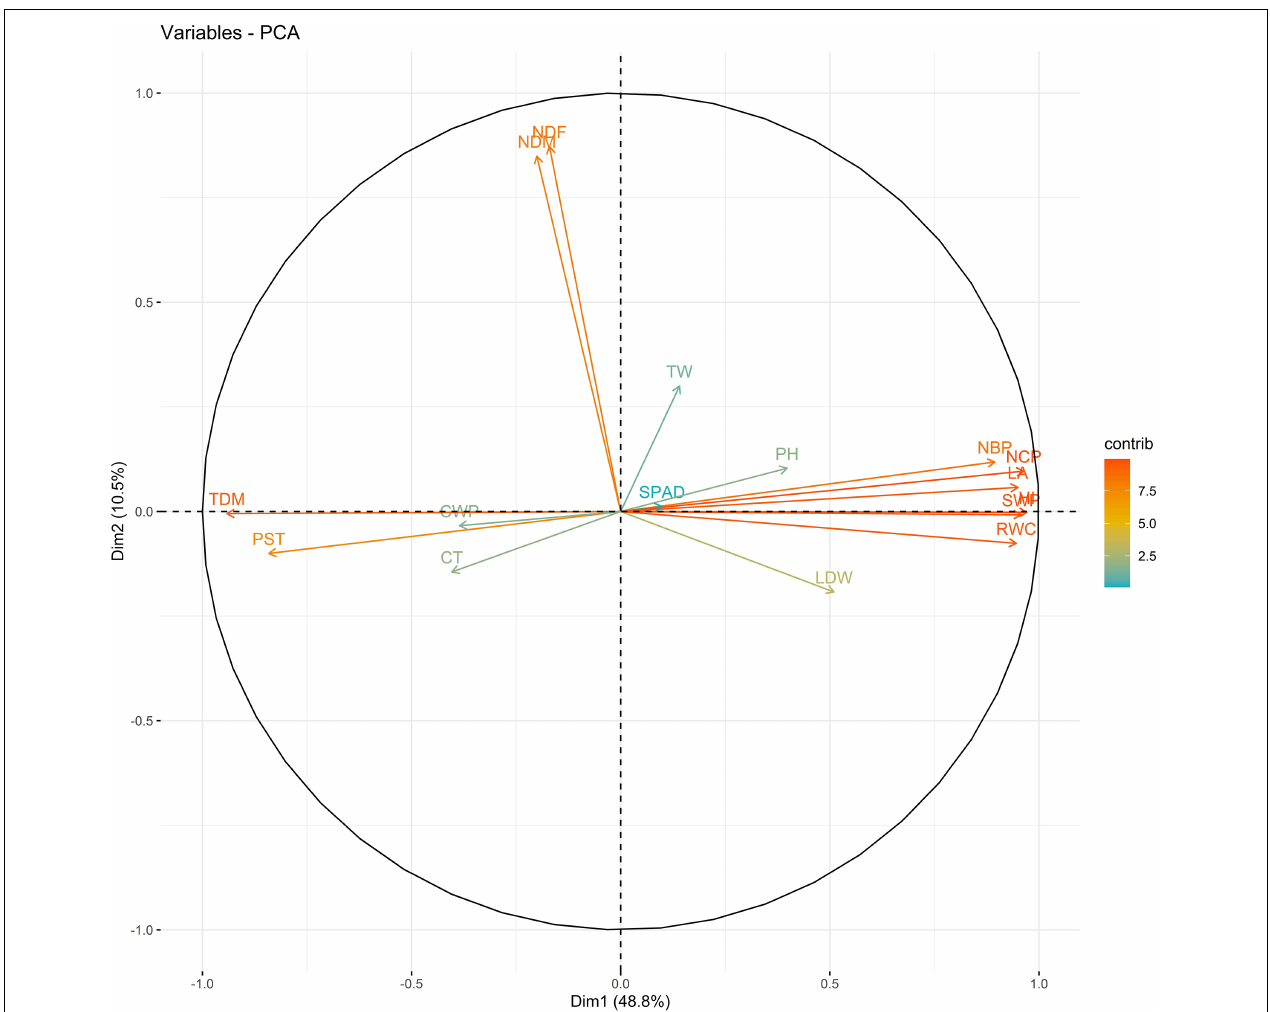
FIGURE 2 | Biplot between PC1 and PC2 showing contribution of various traits during year 2018 season under WS